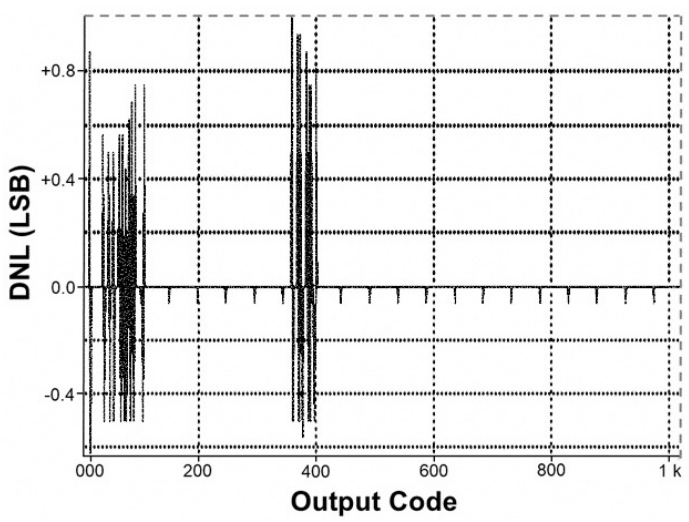
Figure 17. Measured DNLs of the proposed SAR ADC.